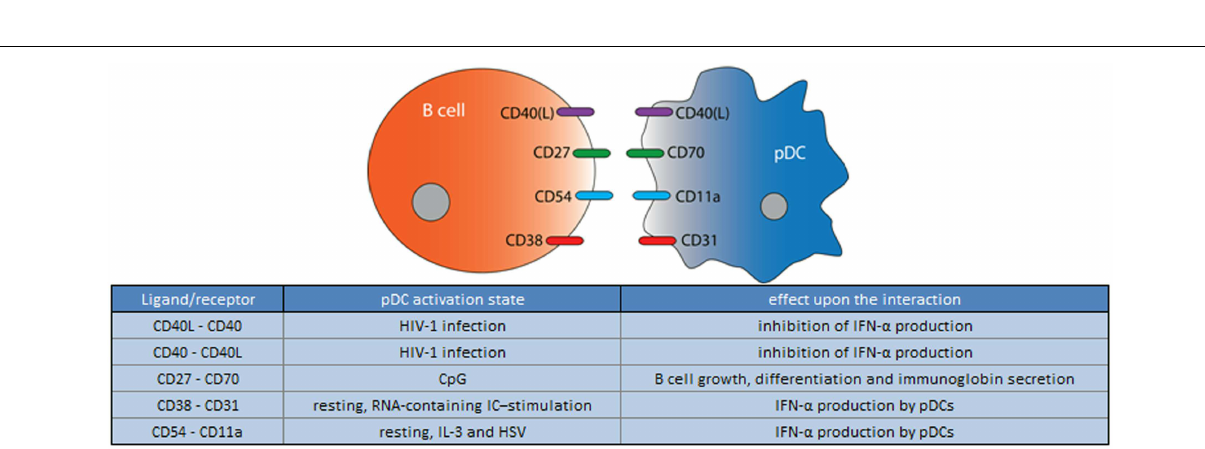
FIGURE 4 | Ligand/receptor paring of a pDC with an iNKT cell and the maturation state/activation stimuli associated with ligand or receptor expression on the pDC surface .